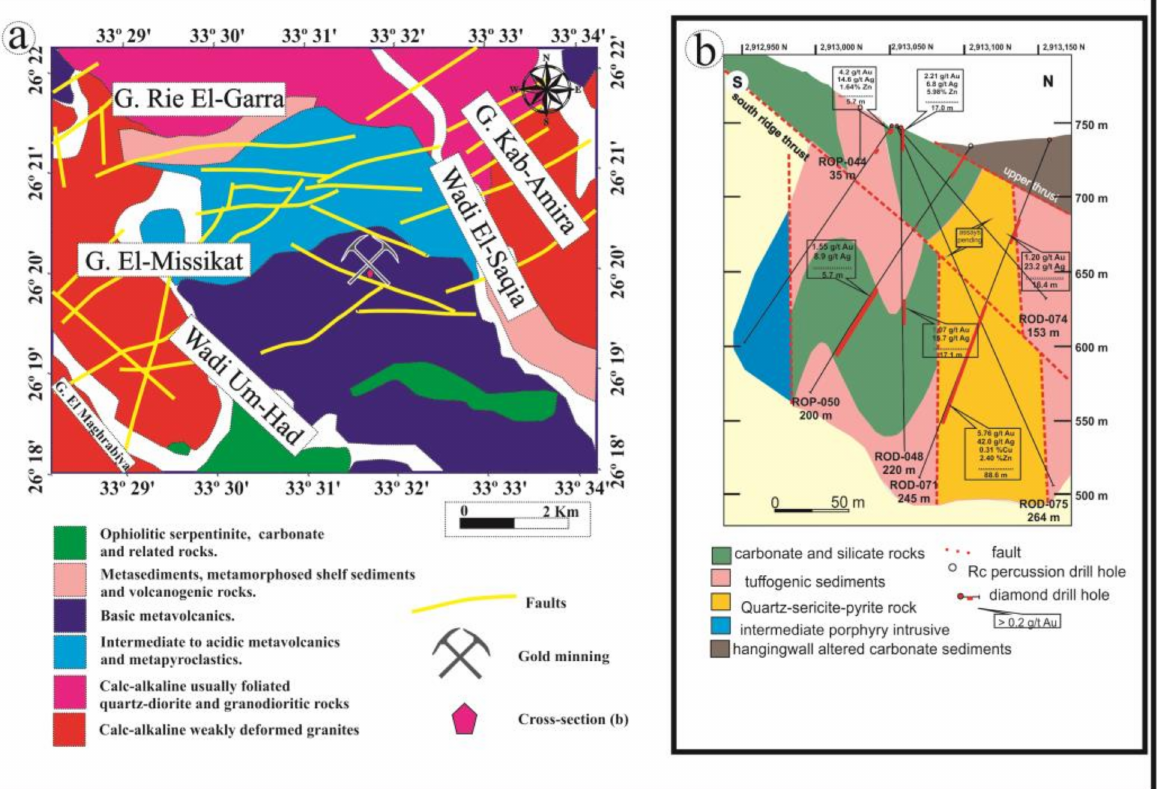
Figure 3. ( a ) Wadi El-Saqia geological map modified after [30]. ( b ) A subsurface geological section in the gold-mine area showing the locations of gold-mineralization zones associated with subsurface faults, modified after